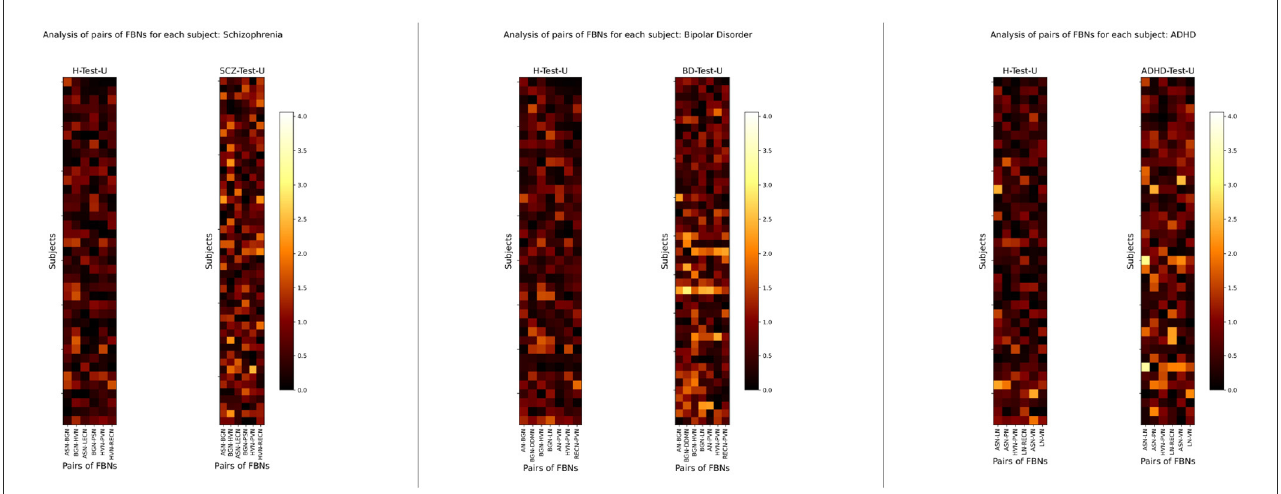
FIGURE6 Individual-level analysis of the absolute values of the differences between the reconstructed and inputted data of the pairs of FBNs that characterize SCZ-Test-U, BD-Test-U, and ADHD-Test-U groups. The color bar ranges between the lowest and the highest values of the absolute difference between the reconstructed and inputted data for the selected features of all subjects used for testing the normative model.